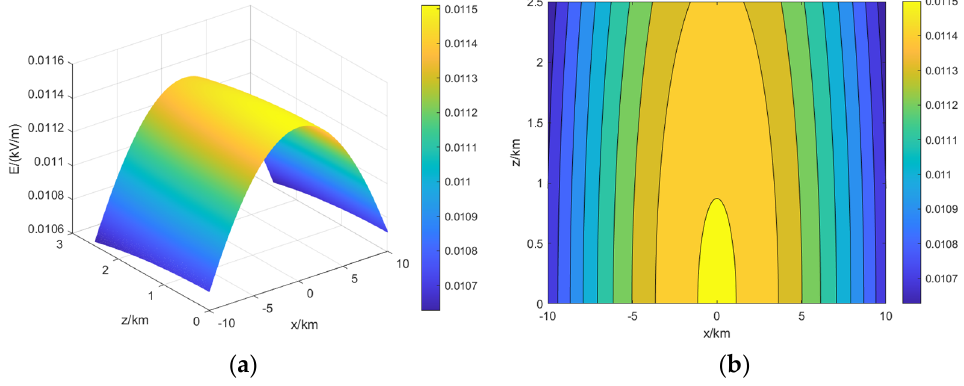
Figure 11. ( a ) Electric field distribution on the longitudinal section while y = 40 km. ( b ) Electric field distribution on the longitudinal section while y = 40.